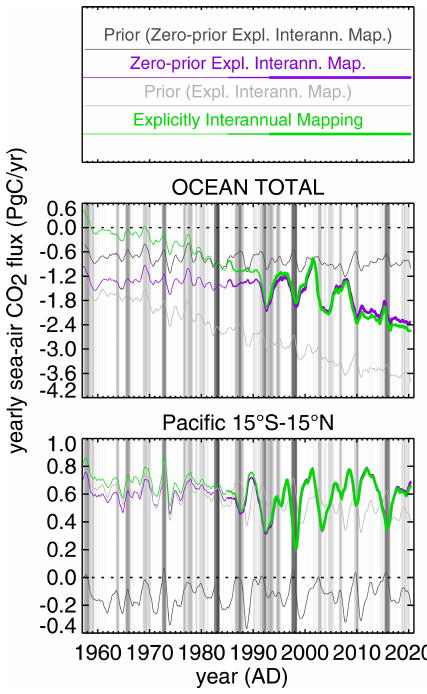
Figure A3. Interannually filtered sea–air fluxes as in Fig. 6 (two example panels only) estimated by the zero-prior explicitly interan- nual p CO 2 mapping (violet) and the explicitly interannual p CO 2 mapping (green) as well as their respective priors (dark and light grey, respectively; note that the designation “zero-prior” refers to = 0, while the a priori sea–air fluxes shown here are in fact f ZE , pri int non-zero owing to the rise in atmospheric CO 2 and the variations in SST). The line width roughly distinguishes the early period with insufficient data constraint (thin) and the more recent period with better constraint (thick). Vertical background stripes as in Fig.